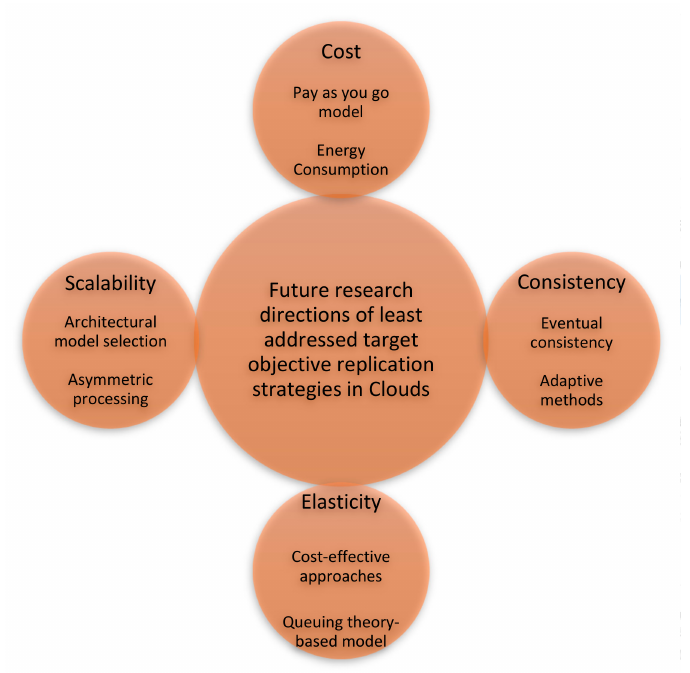
Figure 8. Future research directions of least addressed target objective replication strategies in